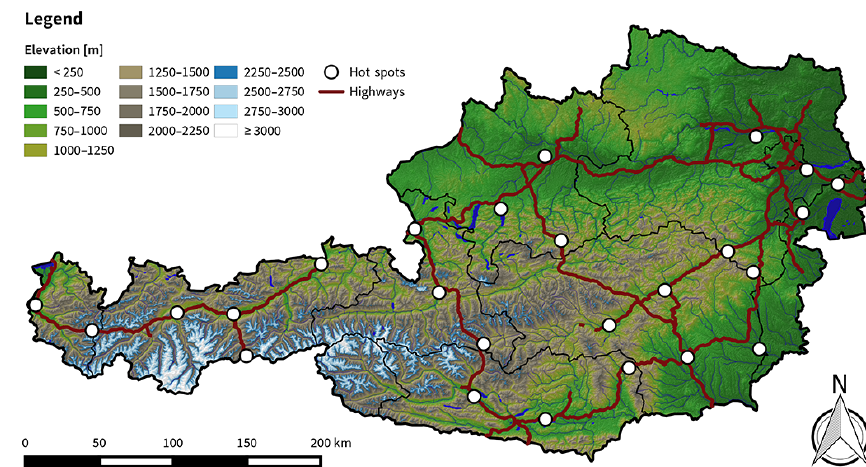
Figure 1. Location of the selected meteorological stations used for extreme value